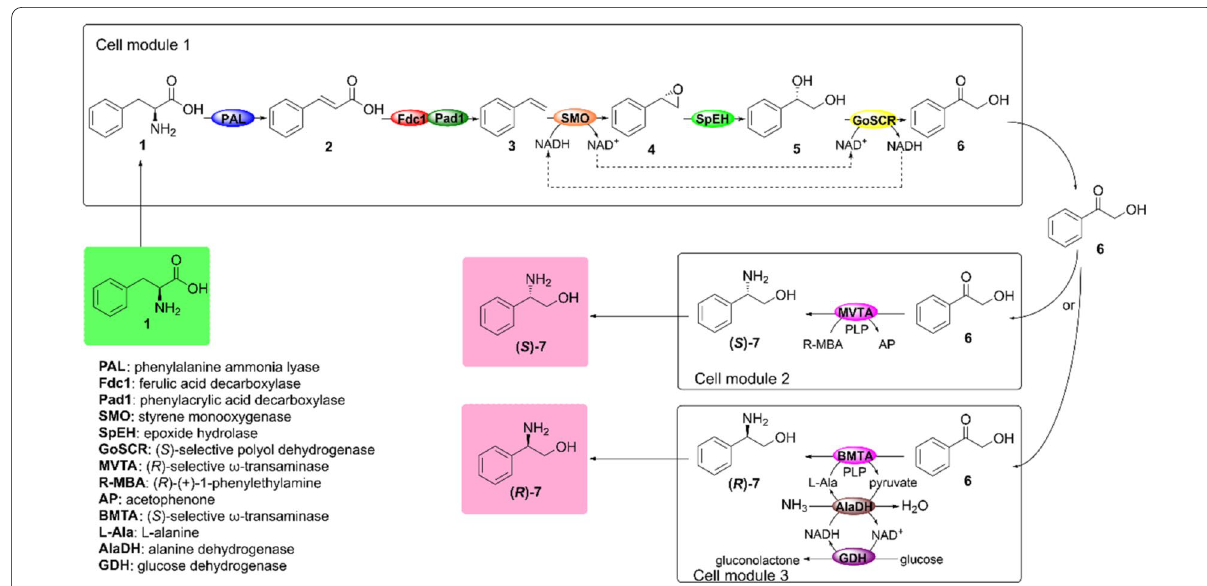
tional file 1: Table S1. After, the PCR products were iso- lated, double digested with the restriction